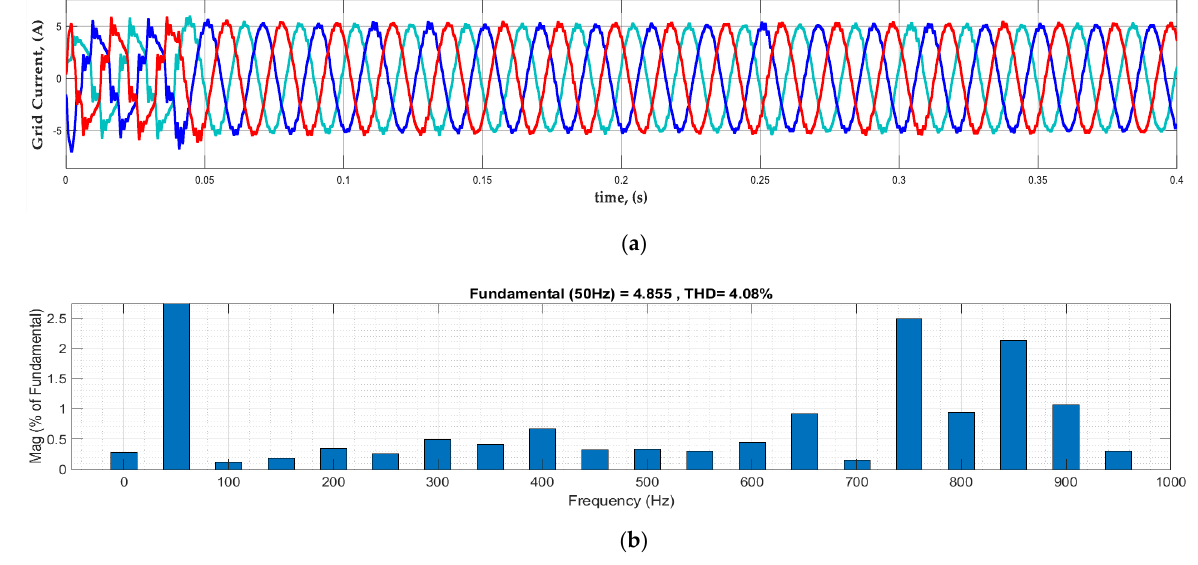
Table 4. Designed HPF performance compared to other authors’ work.